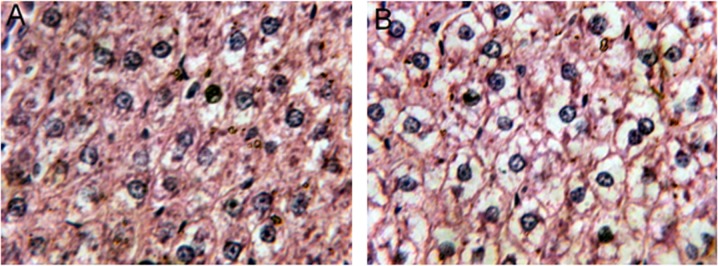
Representative hematoxylin and eosin staining (H&E, 400×) of liver sections.(A) from the control group, (B) from the experimental group. Significant signs of cytoplasm rarefaction and ballooning degeneration were found in the rats from the experimental group, whereas the control group rats had primarily normal cell shapes.